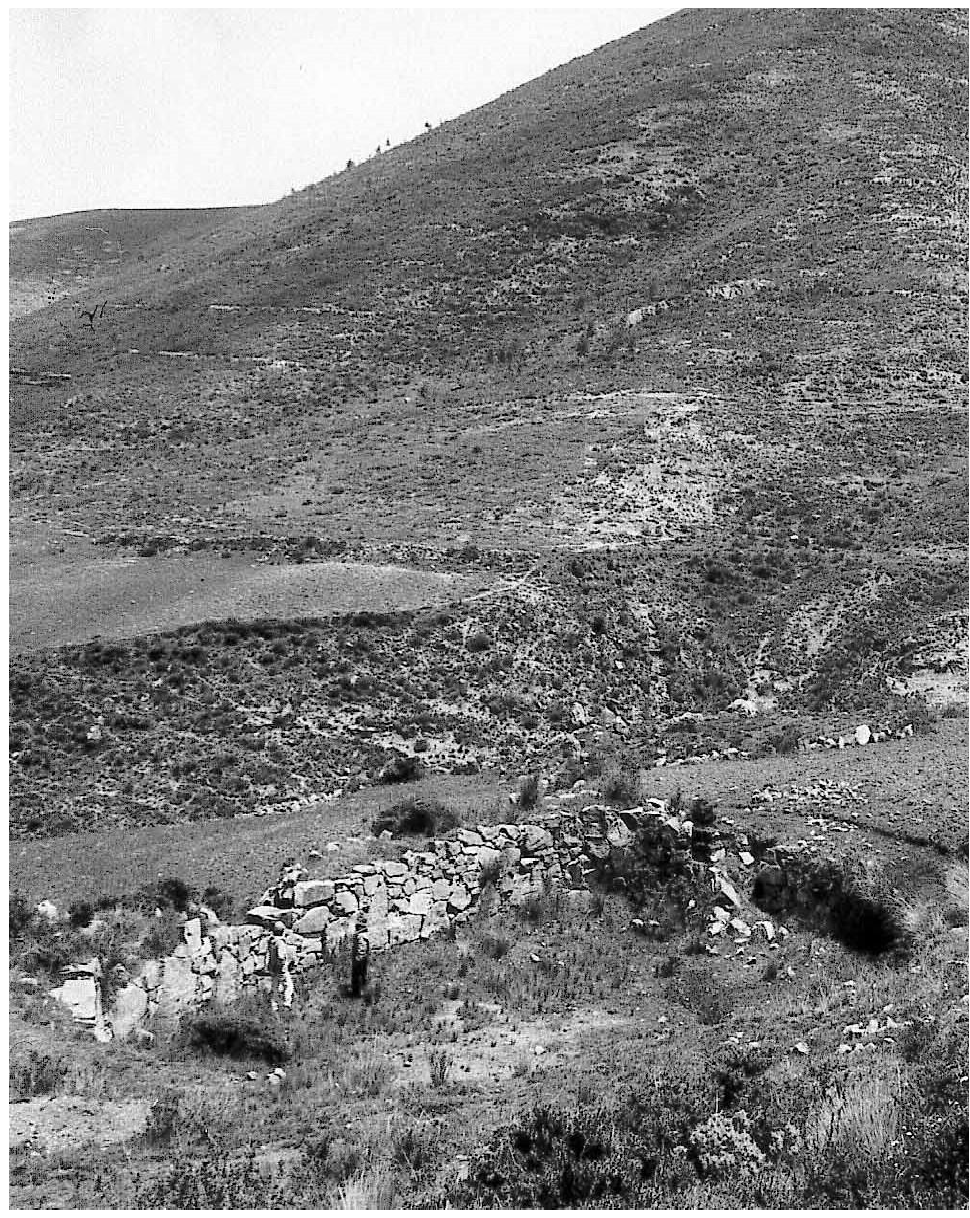
Figure 13. Water reservoir of Nununga [Cj